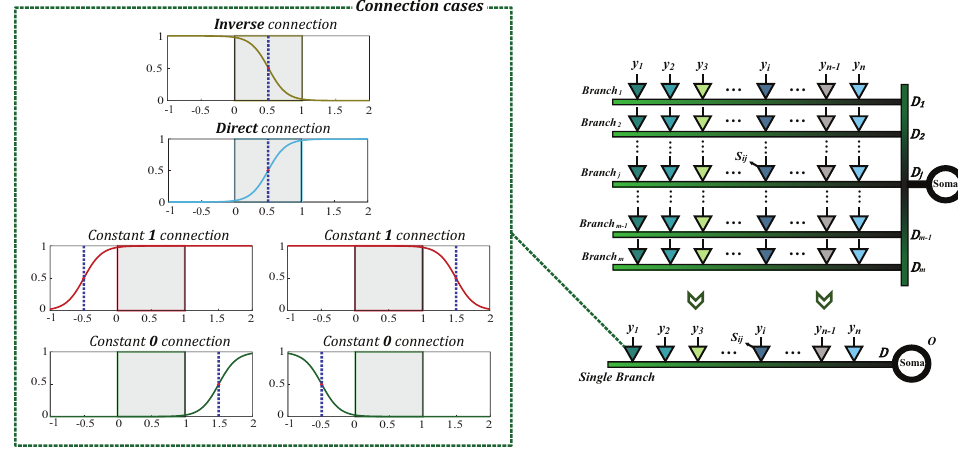
Figure 1. Illustration of the proposed DNR network and the six connection states of the synapse